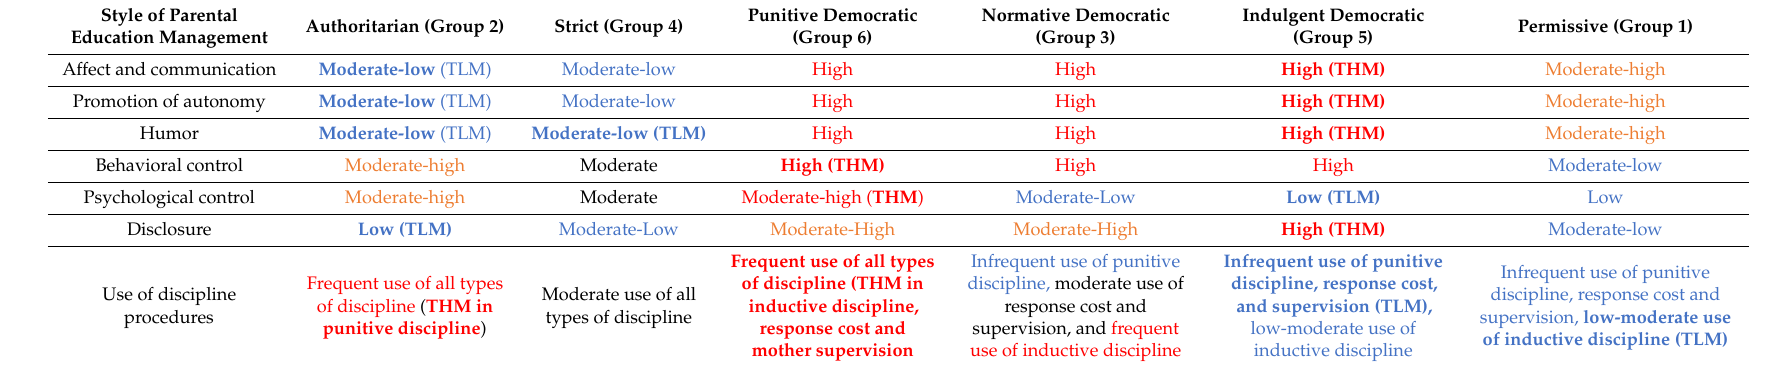
Table 2. Abstract of qualitative description of each style of parental education